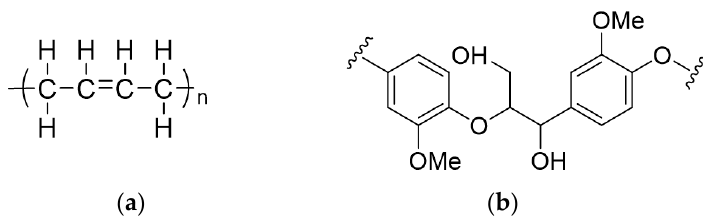
Figure 1. Chemical structure of ( a ) polybutadiene rubber (BR) and ( b ) kraft lignin (KL).